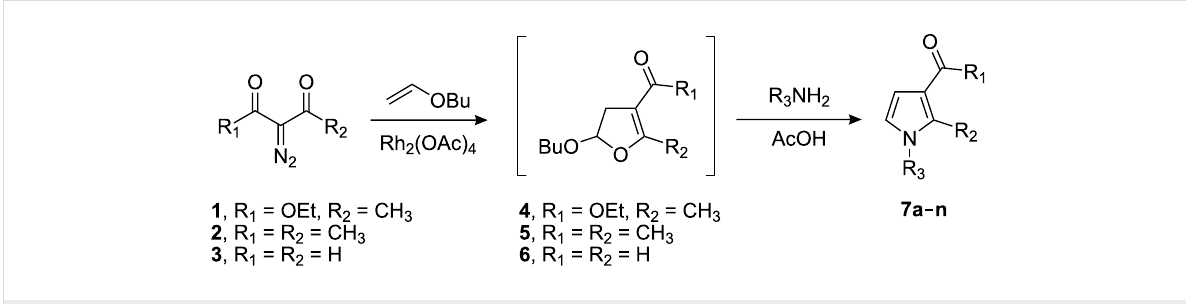
Scheme 1: One-pot synthesis of pyrrole derivatives.